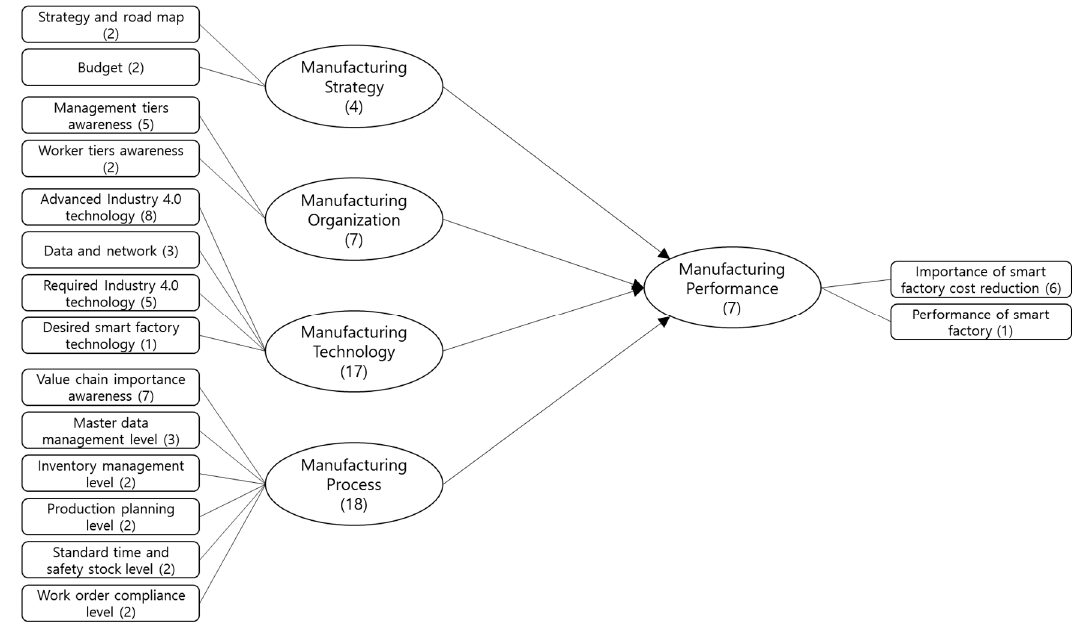
Figure 13. Final Research Model.